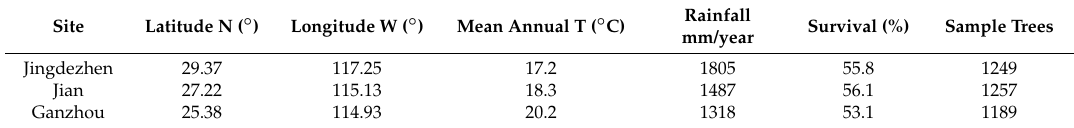
Table 1. Location, climatic conditions and description of the three progeny trials.